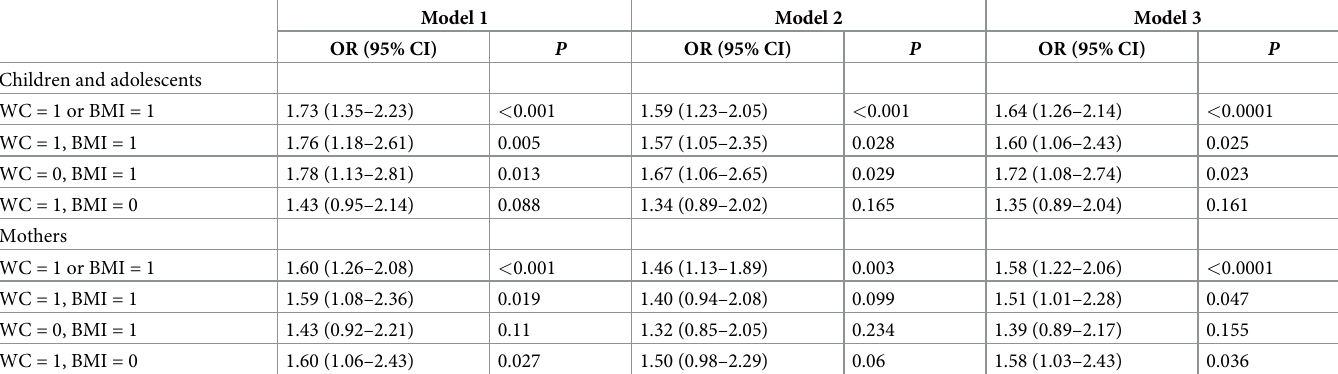
Table 3. Association between dietary knowledge and overweight and obesity in children and adolescents defined by both BMI and